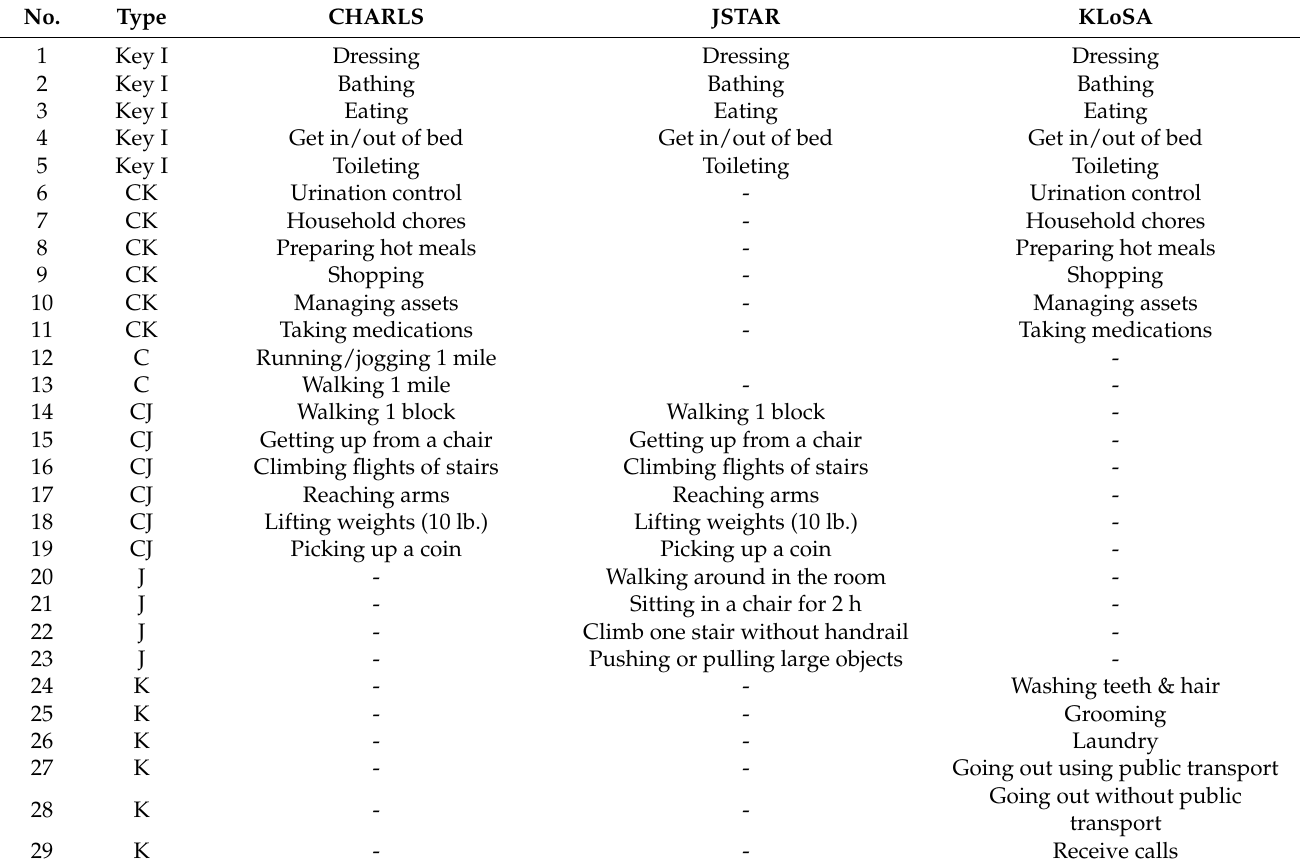
Table 2. ADL and IADL function items in the 2011 CHARLS, 2011 JSTAR, and 2010